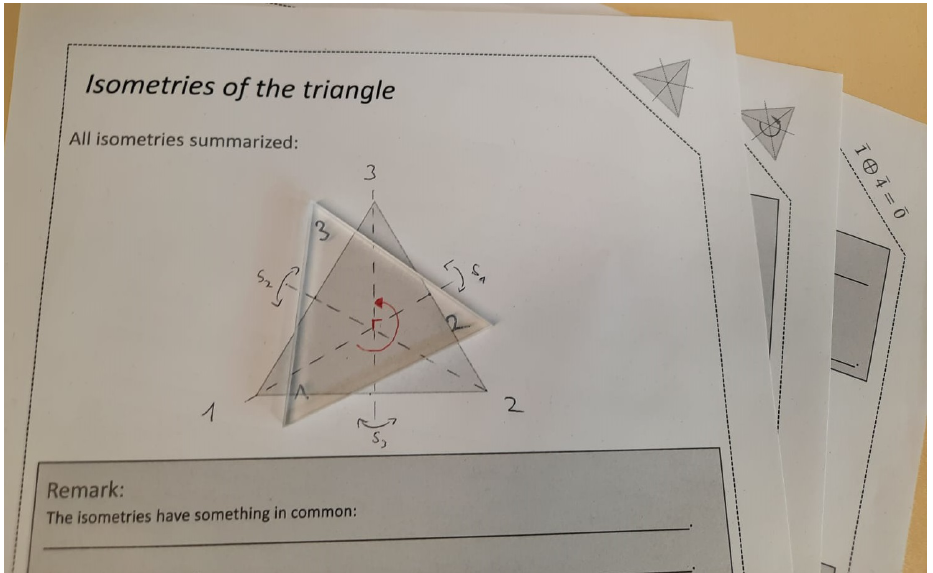
Figure 1. The plexiglass triangles can be used to perform the isometries of the triangle in a hands-on way (own photograph). The teaching materials can be obtained from the corresponding author in either English or